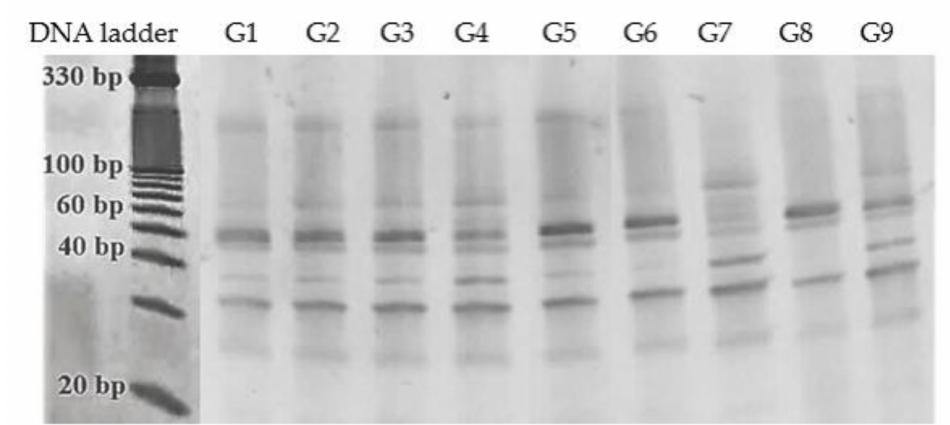
Figure 2. PCR amplification profile generated with miRNA-based primer pair gb-miR482F & gb-miR482R across 9 genotypes of Ginkgo biloba : G1—Nov á Ves nad Žitavou, G2—Topol’ˇcianky, G3—Luˇcenec, G4—Vel’k ý Blh, G5—Rimavsk á Sobota, G6—Pal á rikovo, G7—Šurianky, G8—Košice